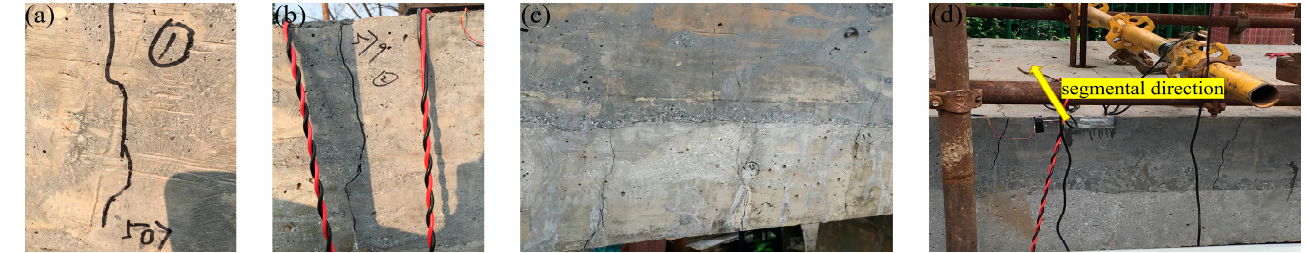
Figure 7. Development of cracks at the beginning of the test: ( a ) the first crack when the load was increased to 507 kN; ( b ) the crack when loaded to 579 kN; ( c ) cracks in midspan tensile zone when the load reached 650 kN; and ( d ) cracks in bottom plate developing along segments when loaded to 650 kN.